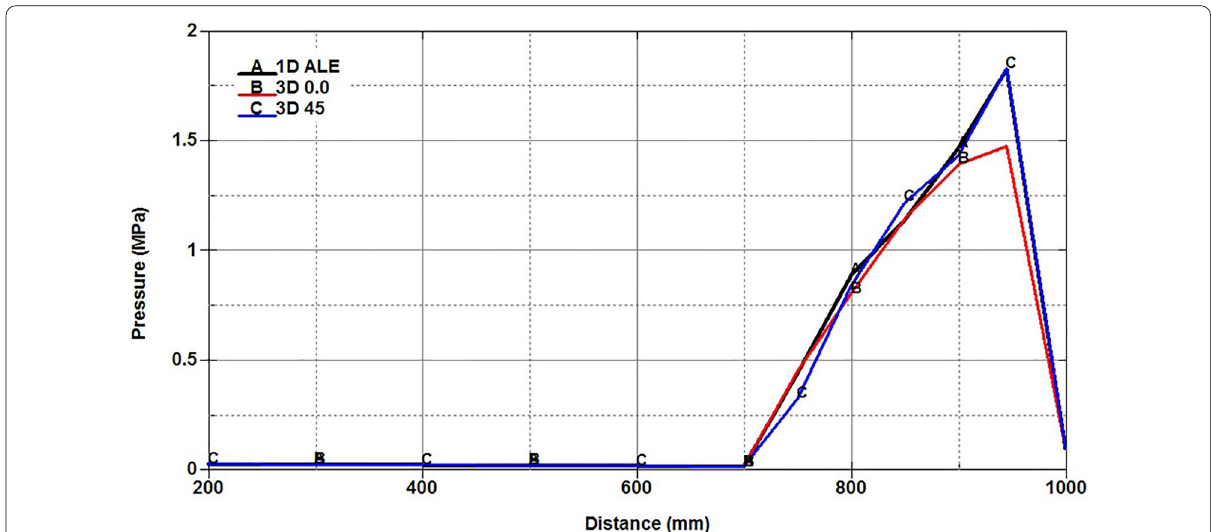
Fig. 14 ALE mapping reliability review analysis result (pressure comparison).